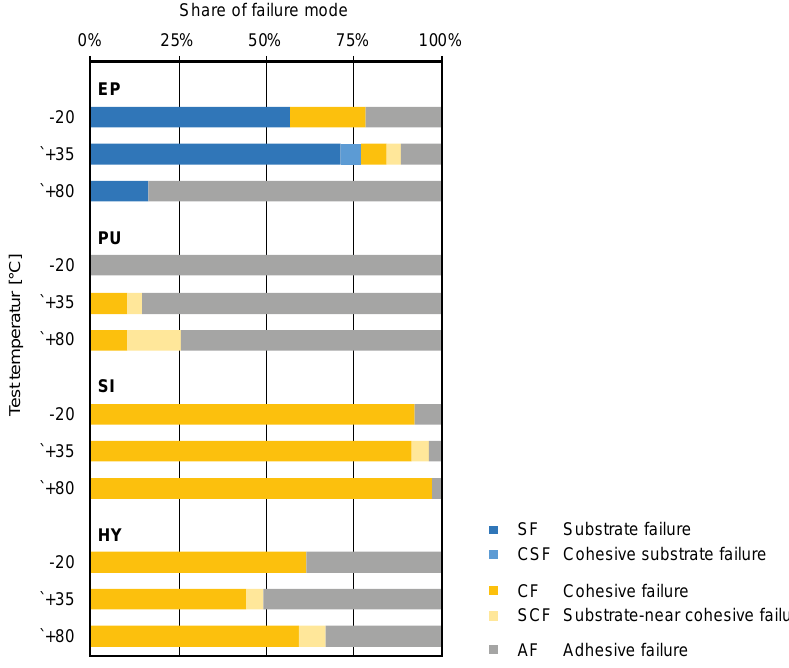
Figure 7: Failure modes of adhesive specimens after temperature conditioning.